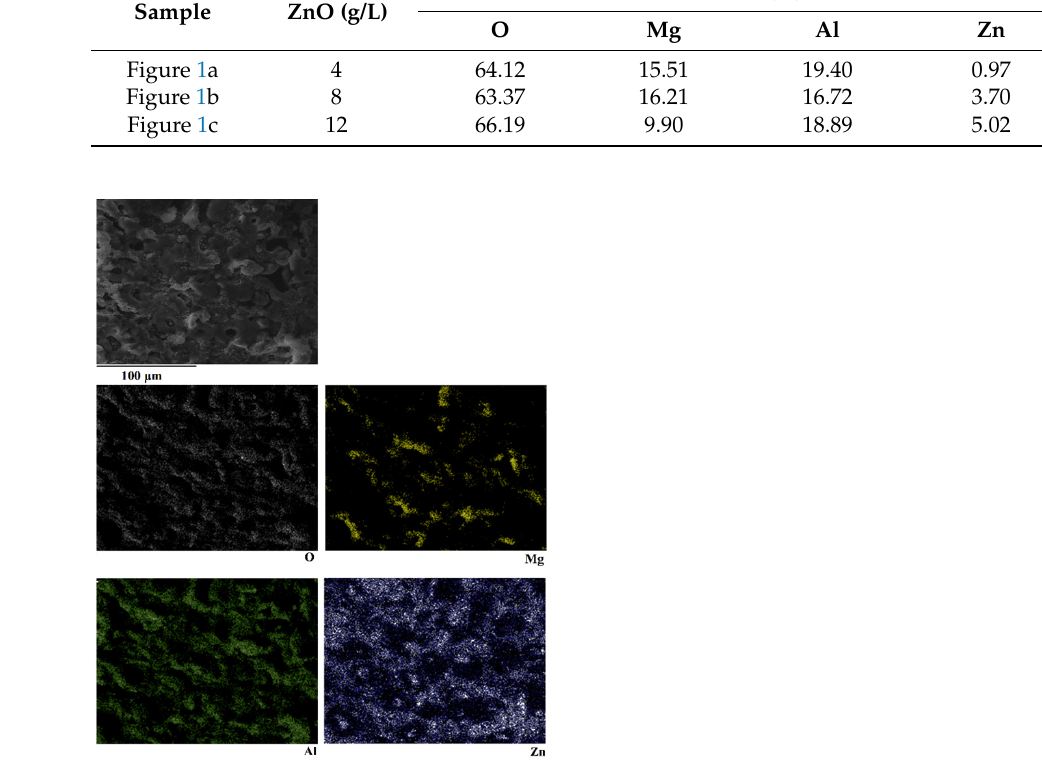
Figure 5. EDS maps of the coating formed in aluminate electrolyte with addition of 12 g/L ZnO particles.